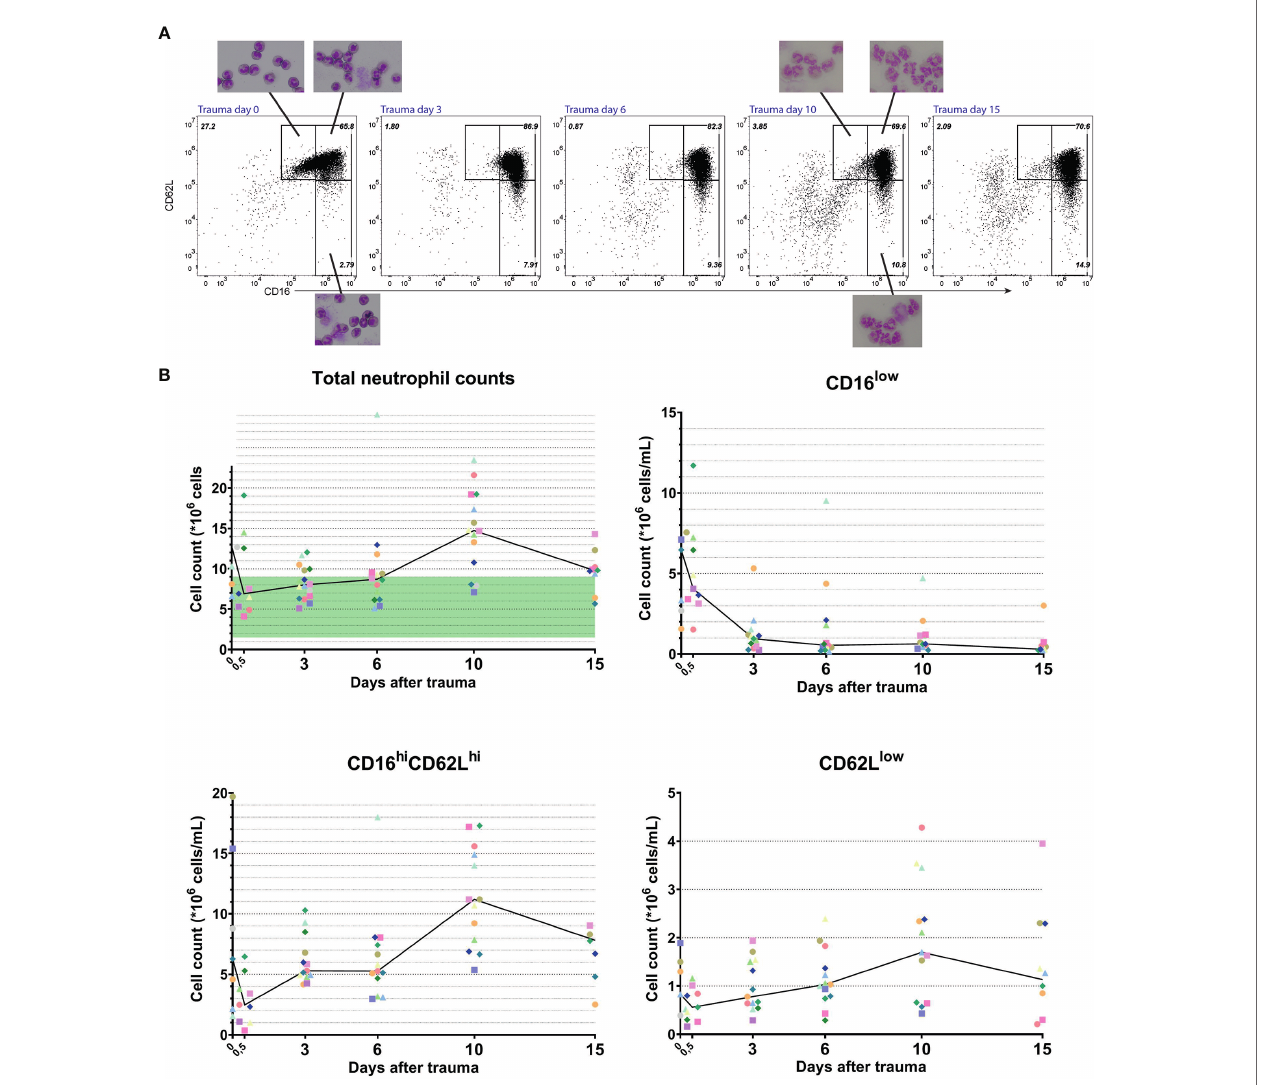
FIGURE 3 | Longitudinal data from multitrauma patients. Representative FACS examples of CD16/CD62L plot of blood from a multitrauma patient. From left to right: at admission (day 0), 3 days, 6 days, 10 days and 15 days after admission to the hospital (A) . Kinetics of cell counts over time of all circulating neutrophils (upper left panel), CD16 low neutrophils (upper right panel), mature CD16 high /CD62L high neutrophils (lower left panel) and CD62L low neutrophils (lower right panel). Data from a unique individual is represented by a unique color. A line is plotted through the medians of every time point. In the upper left panel, the normal range of blood counts for neutrophils is marked by a green area ranging from 1,5 to 9*10 6 cells/mL (B)